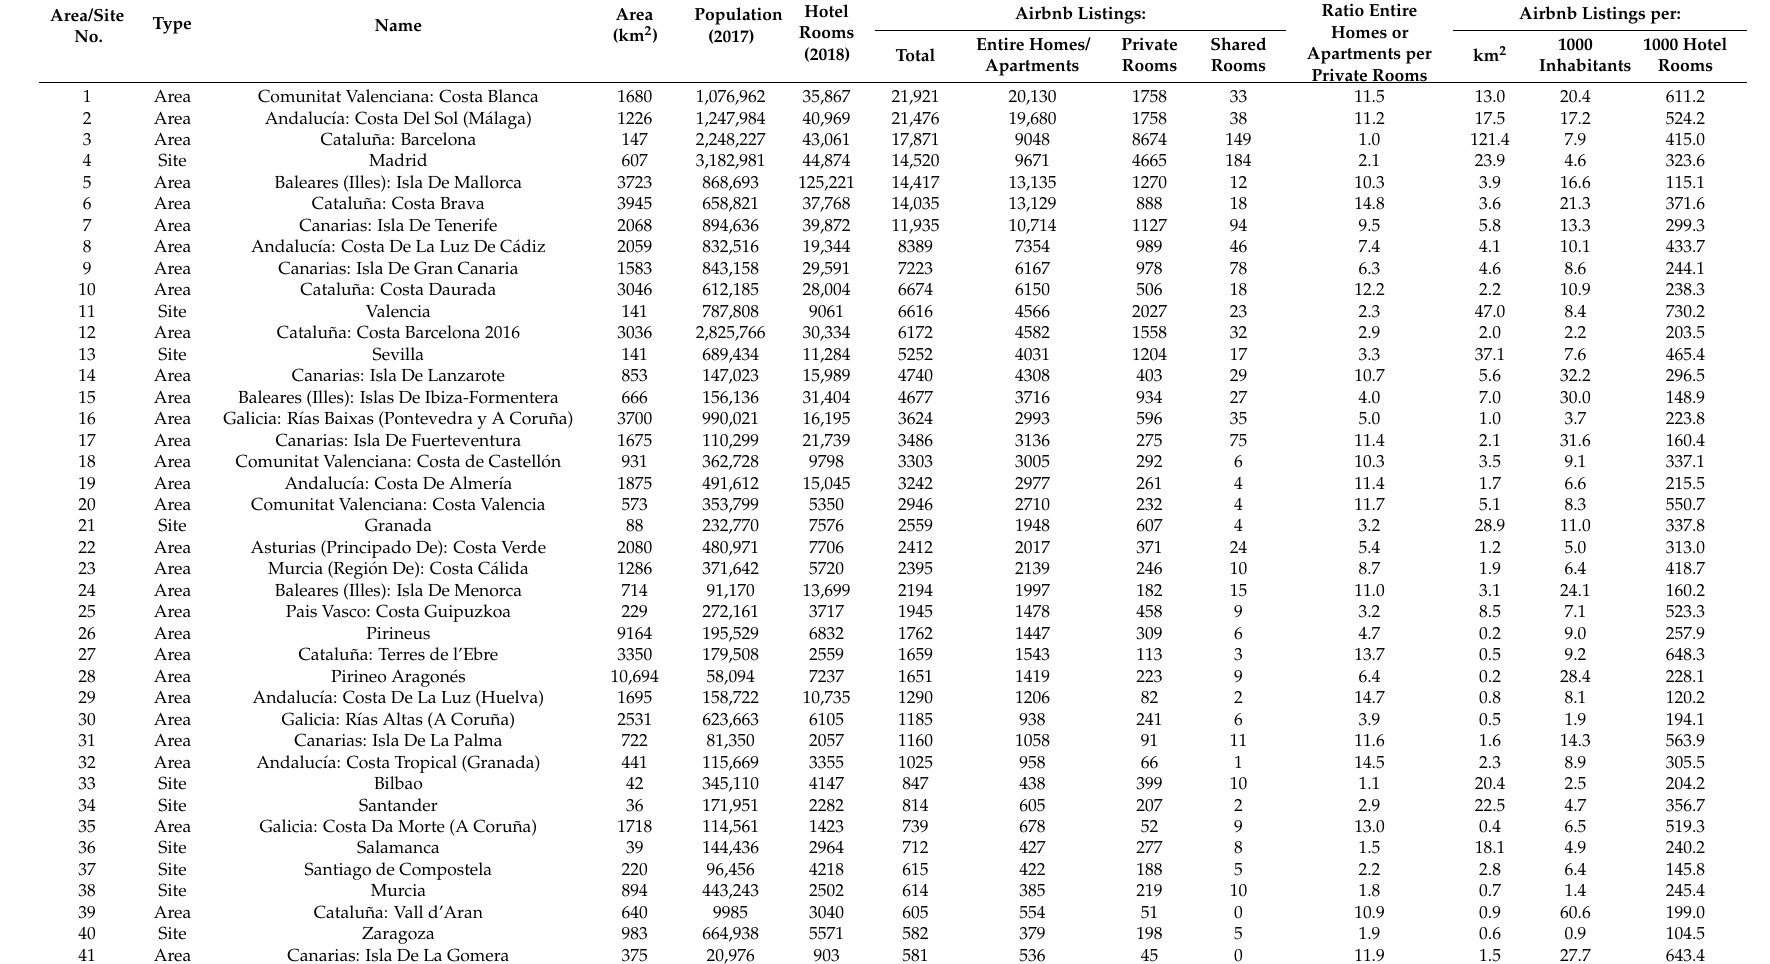
Table A4. Airbnb accommodation supply in tourist